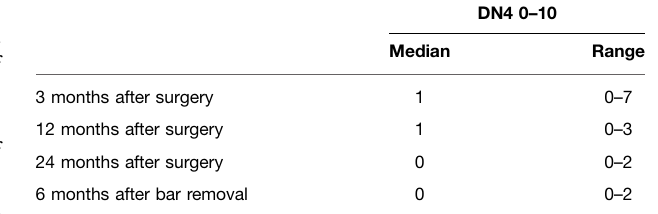
TABLE 5 | Neuropathic pain after